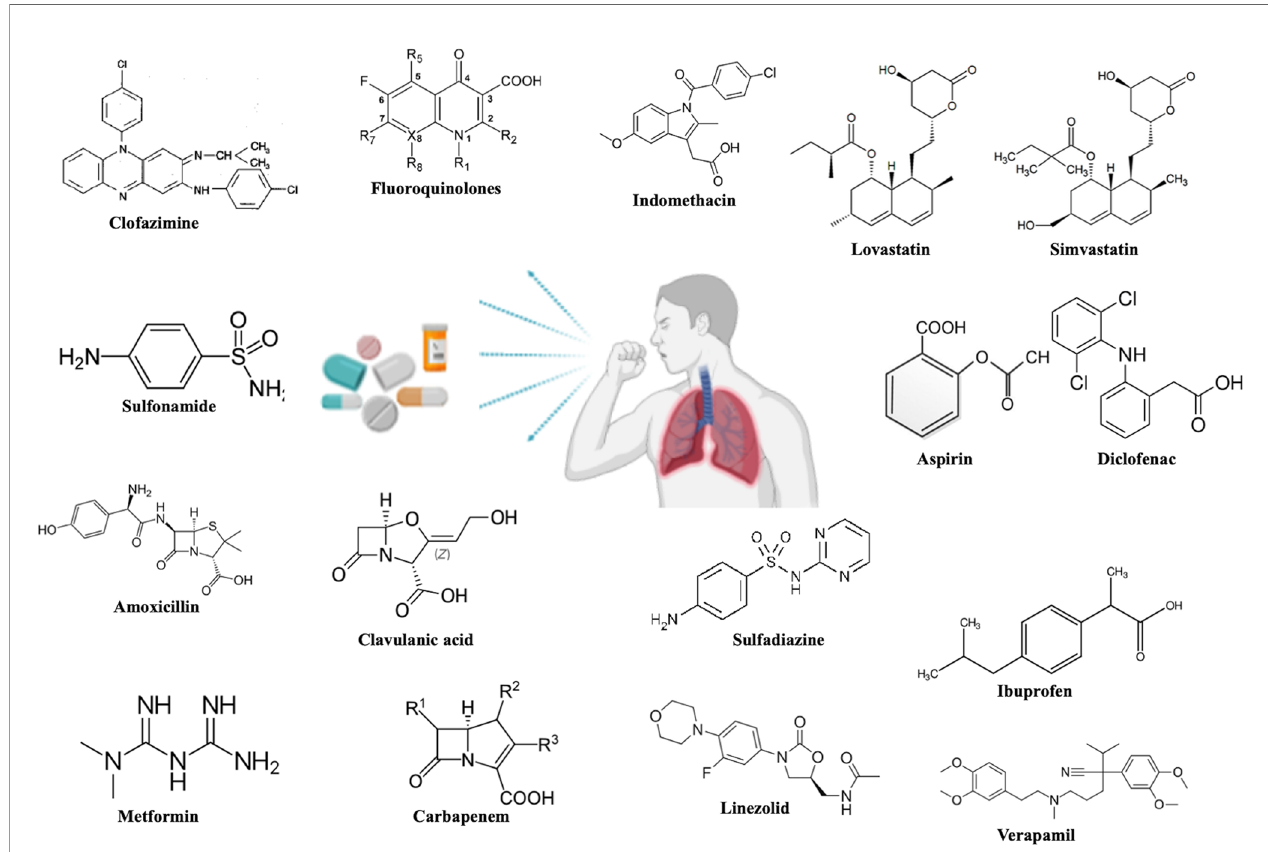
FIGURE 1 | Chemical structures of the proposed repurposed drugs under investigation against TB